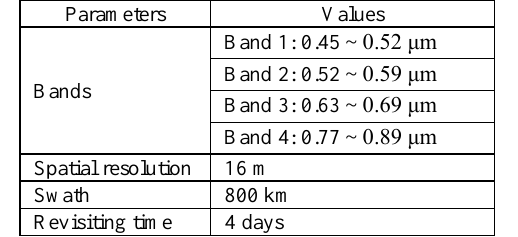
Table 1 . Some key parameters of WFV images of GF1 satellite